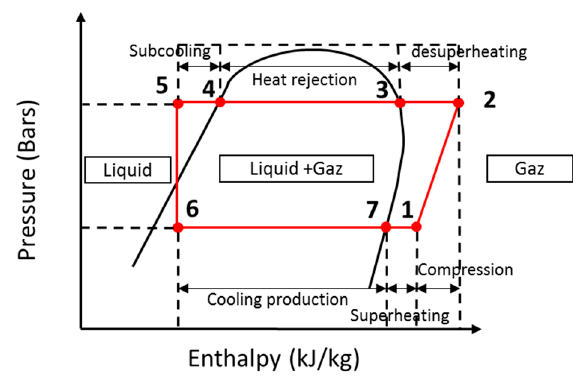
Figure 3. Refrigerating thermodynamic loop.